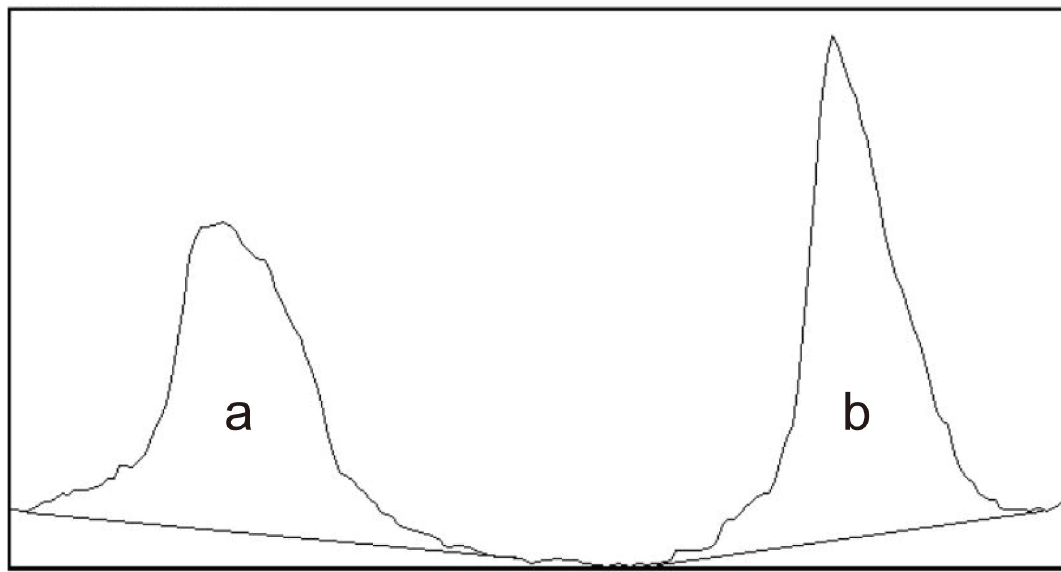
Fig 2. Quantitative analysis of matrix metalloproteinase 9 immunoassay using Image J software version 1.44p (https://imagej.nih. gov/ij/). (a) Reagent band density area. (b) Control band density area.